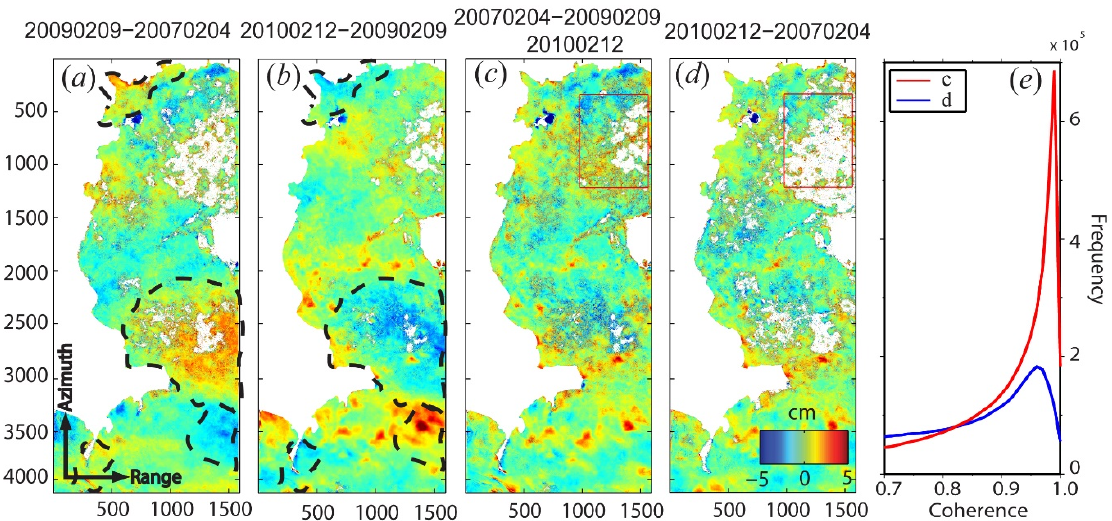
Figure 3. Atmospheric delay and differential interferograms before and after pair wise logic calculation. ( a ) interferogram between image 20090209 and 20070204; ( b ) interferogram between image 20100212 and 20090209; ( c ): stacking interferogram after summing Figure 3a and Figure 3b, aiming to reduce the atmosphere effects of image 20090209; ( d ) interferogram between image 20100212 and 2070204 after using direct interferometry; ( e ) the coherence histogram of Figure 3c–d. Black dashed lines in Figure 3a–b show areas with serious atmospheric delays and red rectangles in Figure 3c–d represent zones selected for coherence comparison. Red and blue solid lines in Figure 3e represent the coherence histogram of Figure 3c,d. (Date format: yyyymmdd).